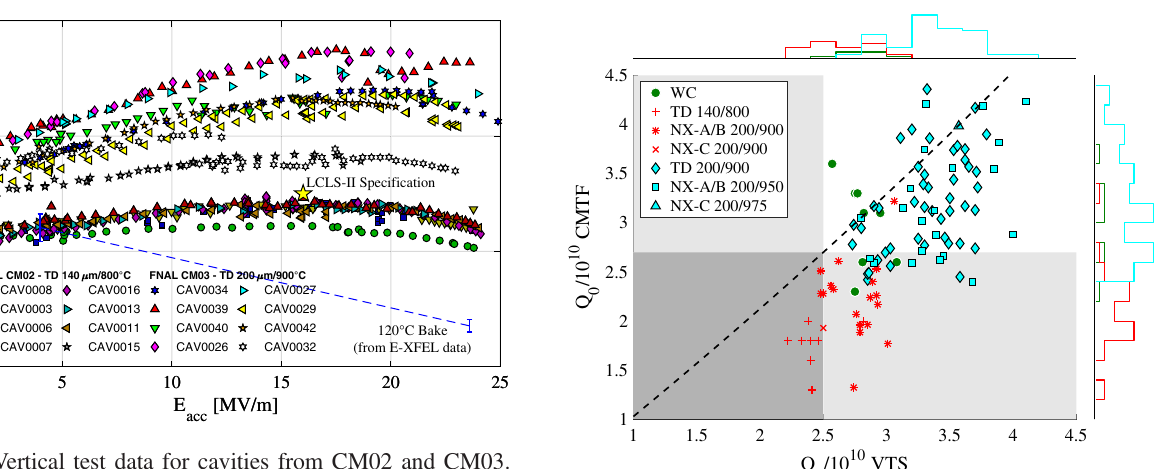
FIG. 7. Vertical test data for cavities from CM02 and CM03.